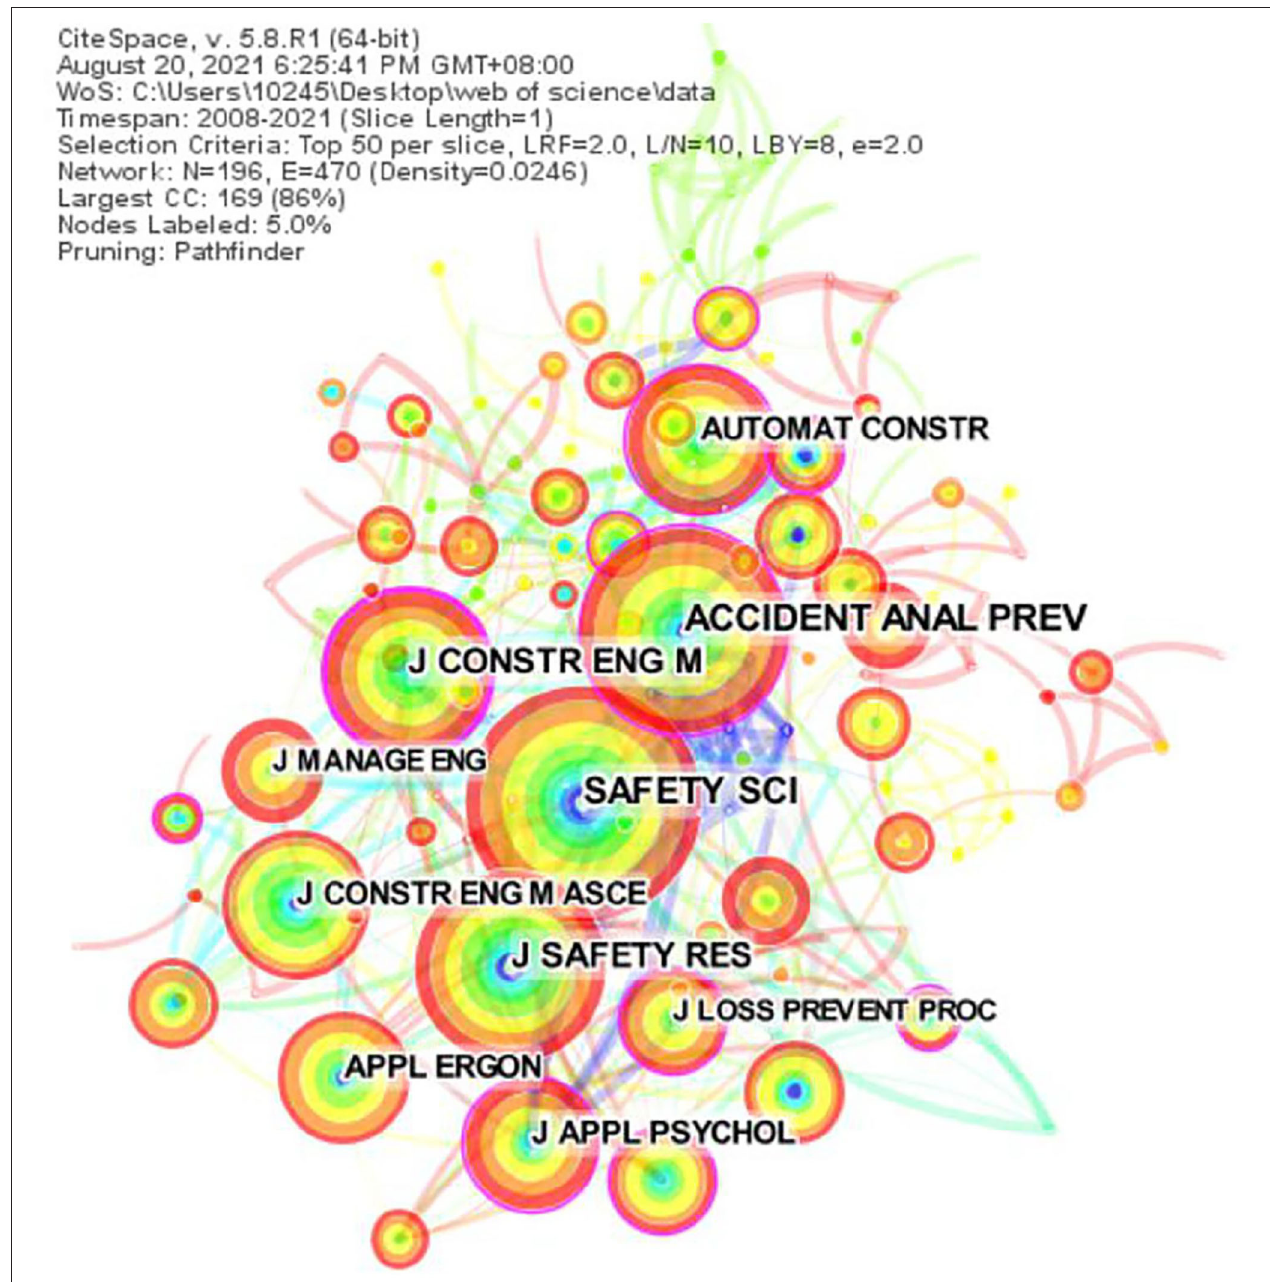
FIGURE 3 | The result of literature publication source